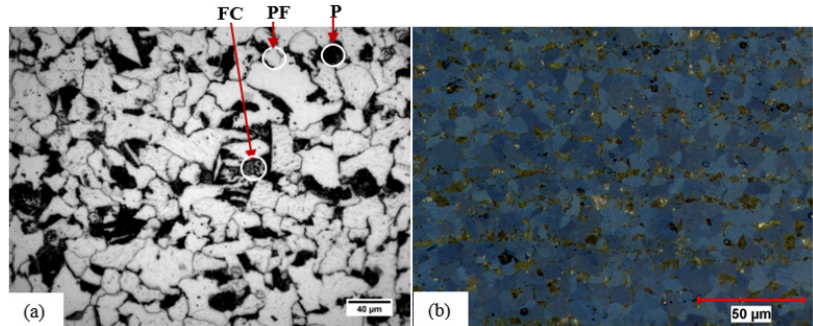
Figure 4: Optical microstructure characterization of FGHAZ for S-SAW. (a) 2% Nital etching and (b) Klemm I etching.